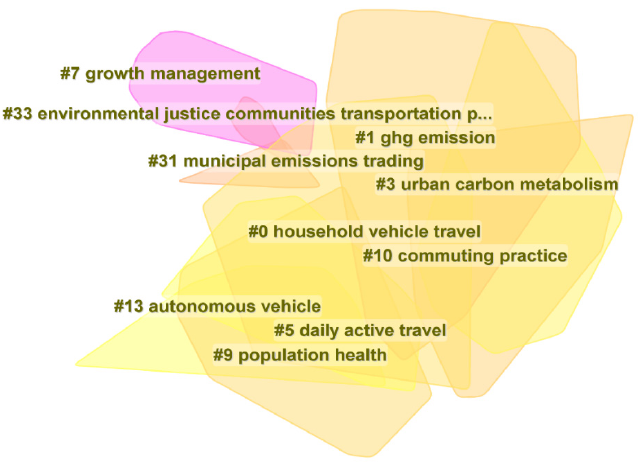
Figure 4. Document co-citation convex hull of clusters. The “#” and number indicate the serial num. Table 2. Summary of the largest ten clusters.